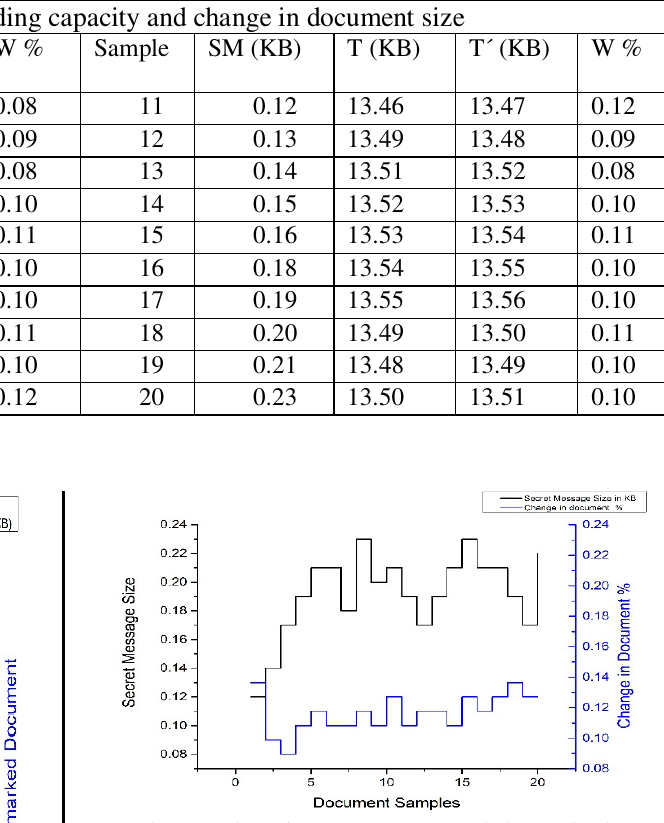
Fig. 12: Size of secret message and change in the document 8.2 Imperceptibility